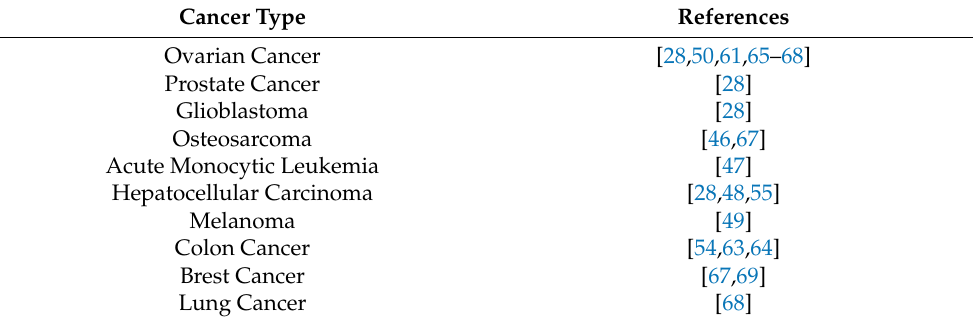
Table 1. RANBP1 involvement in human